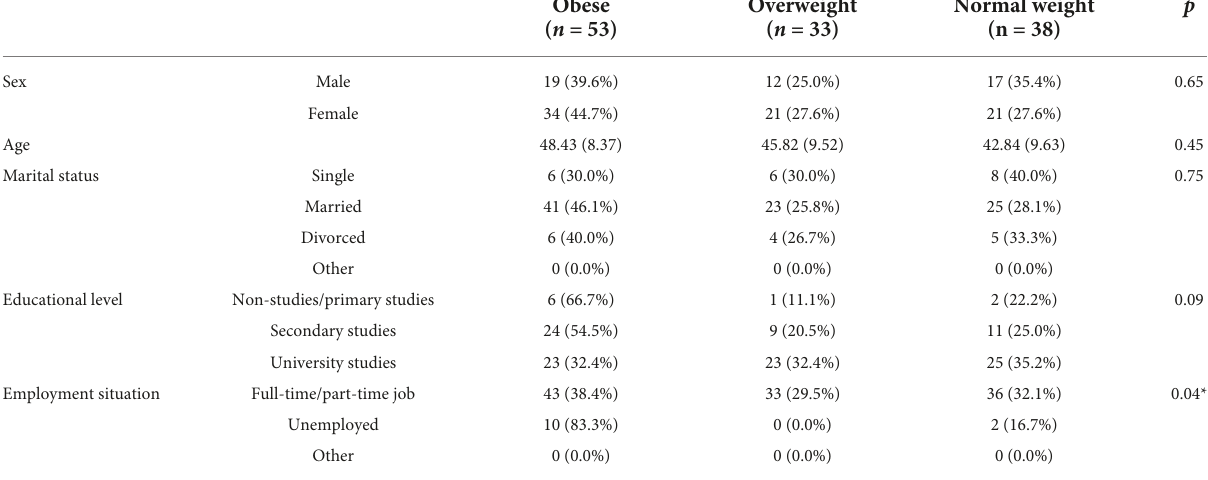
TABLE 1 Frequency and percentage of sociodemographic characteristics for participants in each